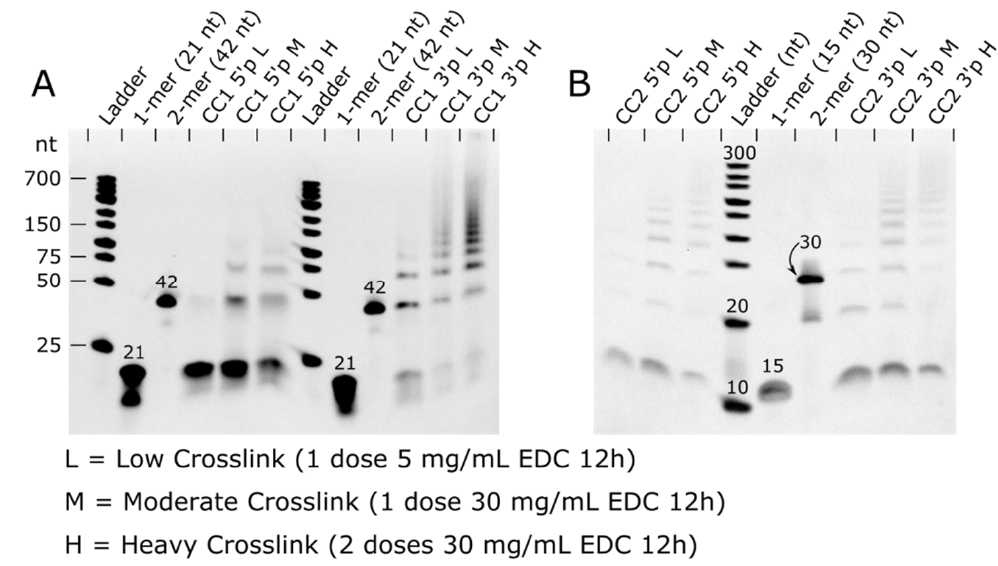
Figure 4. TBE-urea gels of: ( A ) CC1; and ( B ) CC2 chemical ligation. In both co-crystals, additional ligation was achieved with increased EDC concentration and a second EDC dose. ( A ) A 10% TBE-urea gel of CC1 illustrating a much-improved ligation product distribution for 3 ′ vs. 5 ′ phosphates. ( B ) A 15% TBE-urea gel of CC2 illustrating a modestly improved ligation product distribution for 3 ′ vs. 5 ′ phosphates. Assigned band sizes are given in nt.